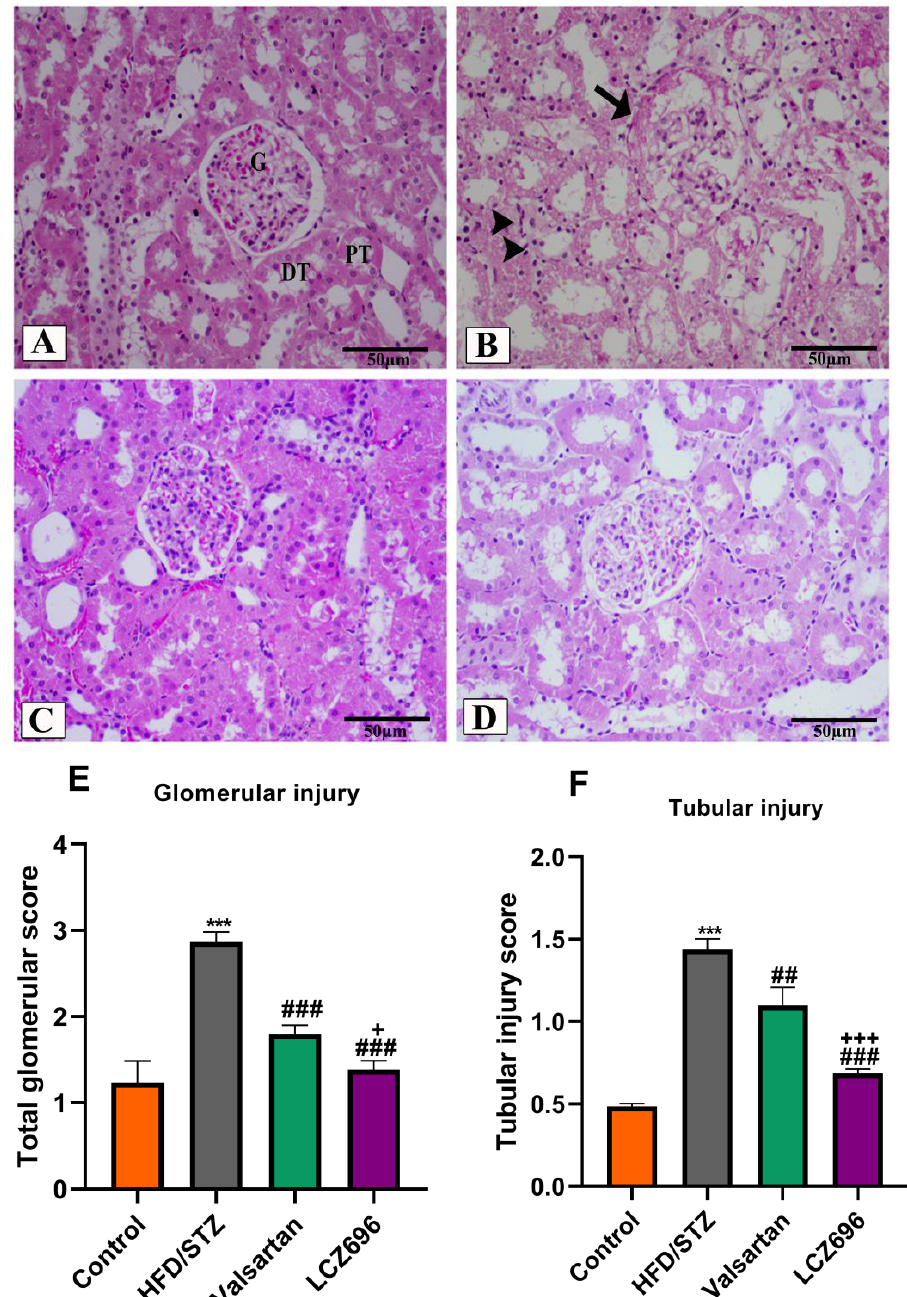
Figure 5. Renal cortex photomicrographs of H&E-stained kidney sections from control ( A ), HFD/STZ- induced rats ( B ), valsartan-treated group ( C ), and LCZ696-treated animals ( D ). The renal cortex of the control group displays normal proximal convoluted tubules (PT), distal convoluted tubules (DT), Bowman’s capsule, and glomerulus structures (G). The renal cortex of animals given HFD/STZ exhibited enlargement of the urinary space, thickening of the basal membrane of the glomerulus (arrow), and infiltration of inflammatory mononuclear cells (head arrow). Glomeruli and renal tubules were significantly improved in the renal cortex of HFD/STZ rats treated with valsartan and LCZ696. Damages to the glomeruli ( E ) and tubules ( F ) in the kidneys of rats from different groups were assessed semi-quantitatively, data are presented as mean ± SEM, n = 6, *** p < 0.001 versus control; ### p < 0.001 and ## p < 0. 01 versus HFD/STZ; + p < 0.05 and +++ p < 0.001 versus valsartan. H&E, scale bar = 50 µm.